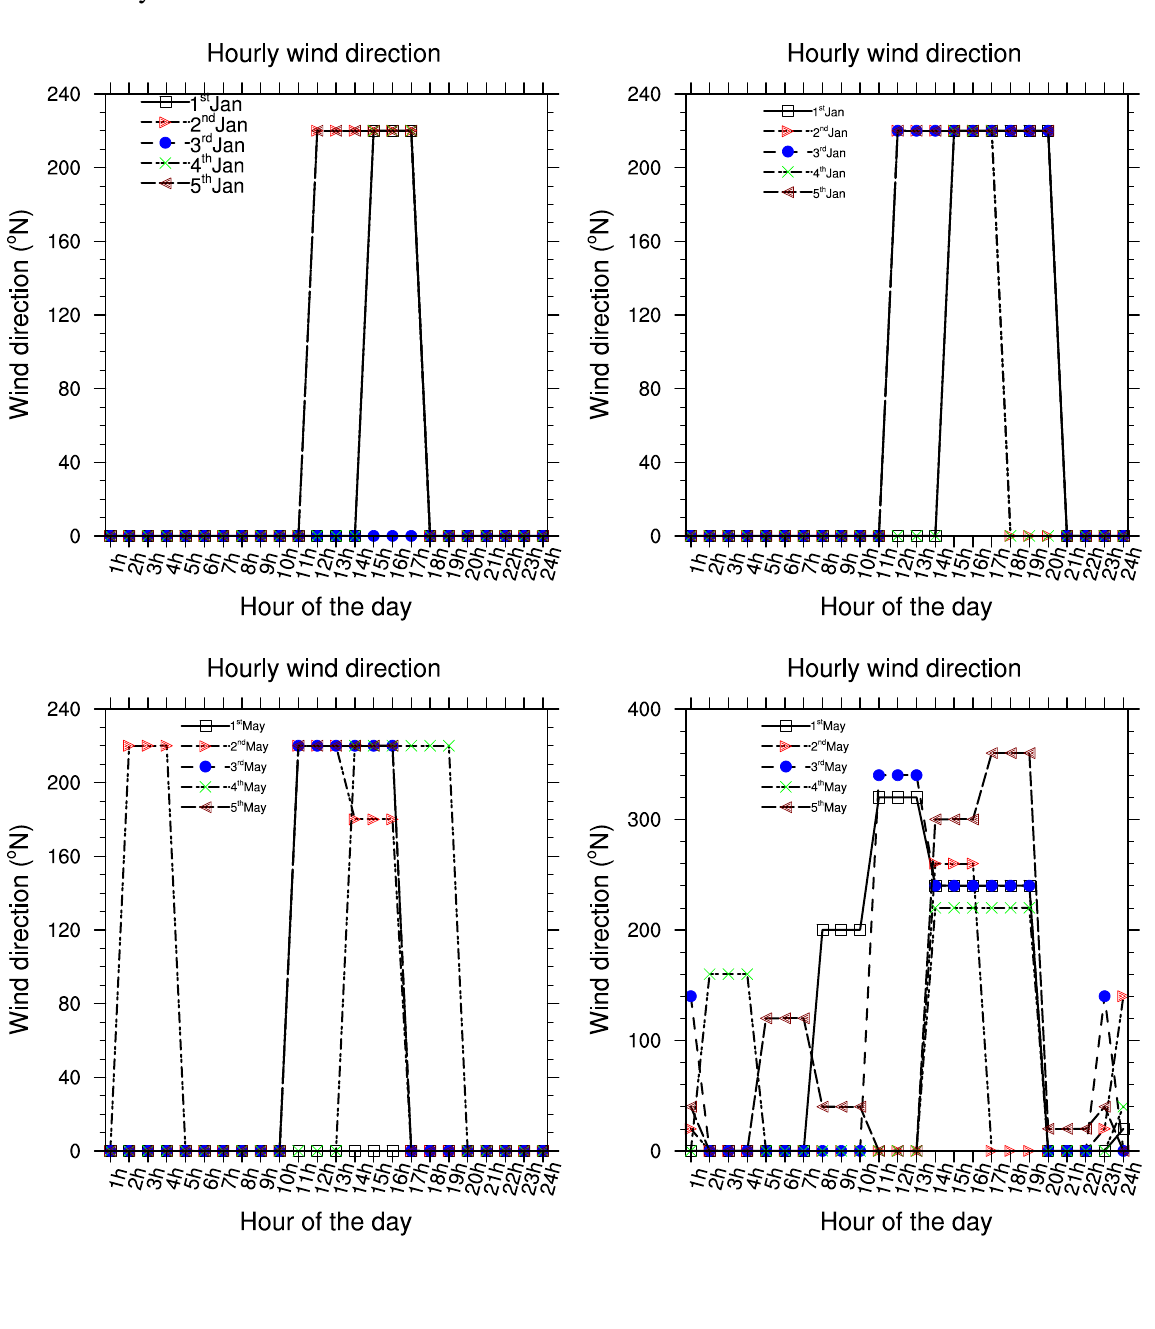
Figure 2. Daily wind direction for the first five days of the months of January, May and August from 2002 to 2003. The first label is for the year 2002 and the second label (column) is for the year